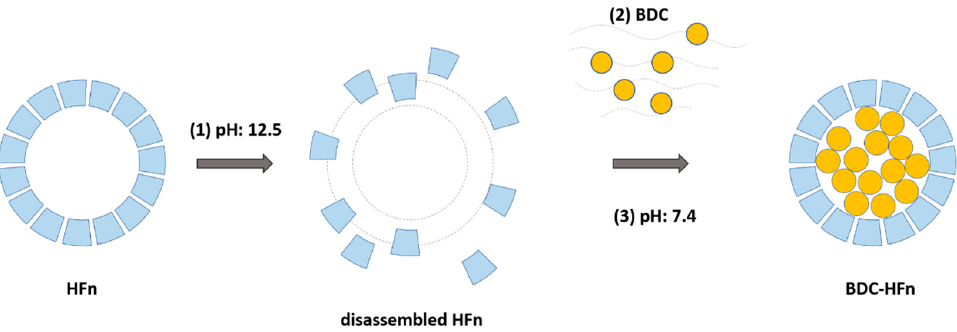
Figure 1. Schematic representation of the protocol used for the preparation of BDC-HFn.